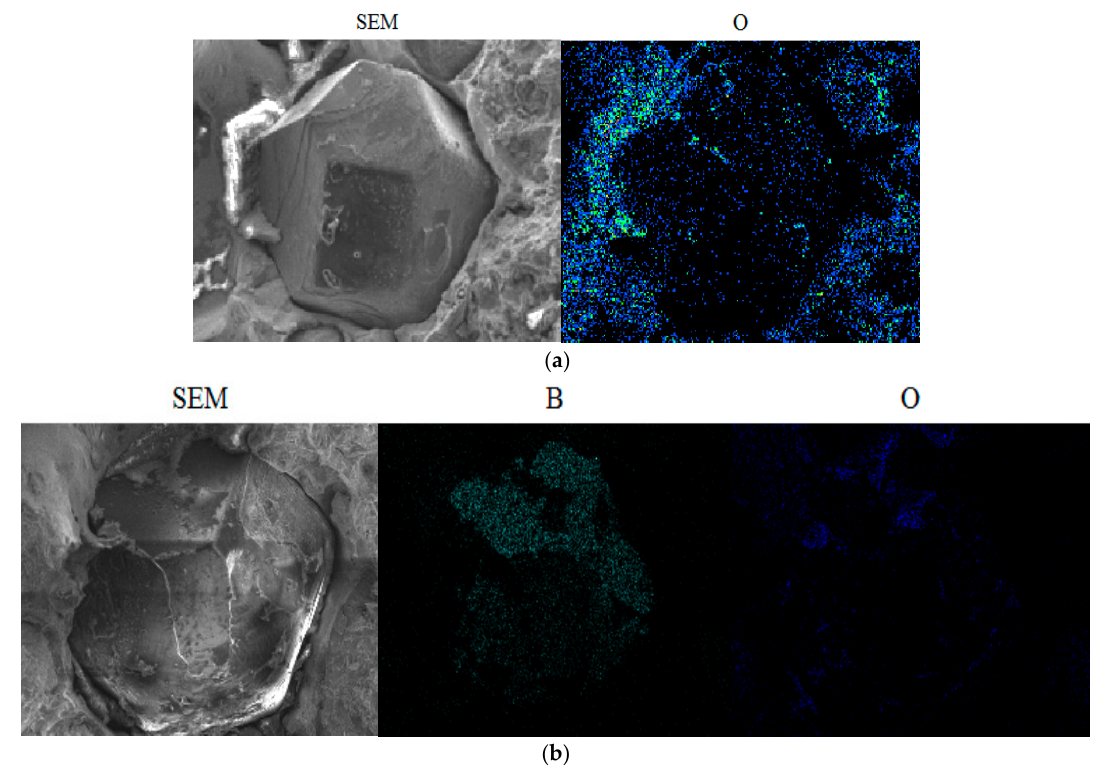
Figure 6. ( a ) O on the diamond surface of Fe-based diamond composites; ( b ) B and O on the diamond surface of Fe-based diamond composites with B.